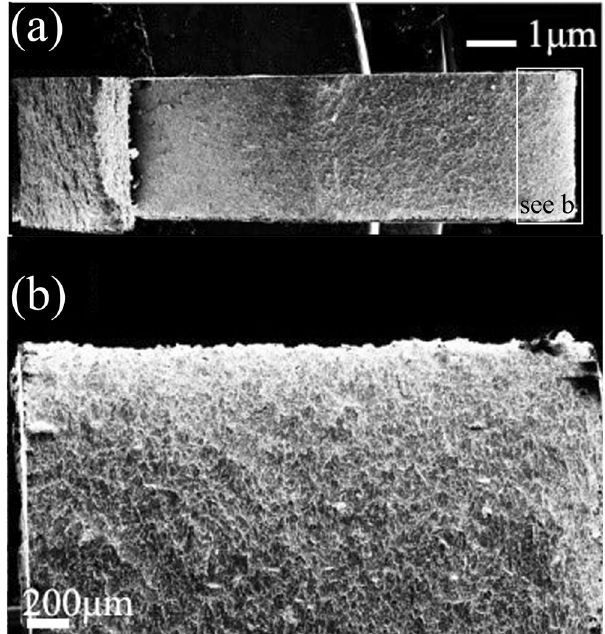
Figure 10. Fracture surfaces of the Charpy impact un-treated commercial WL10 sample at 873 K, where no laminate structure was observed.